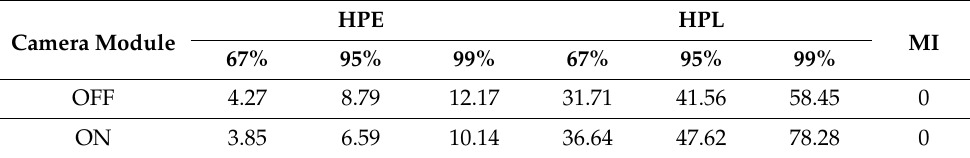
Figure 6. HPE for the whole track—1800s. Table 1. HPE, HPL and MI with a Kalman filter and proposed camera-based aiding algorithm. HPE Camera Module